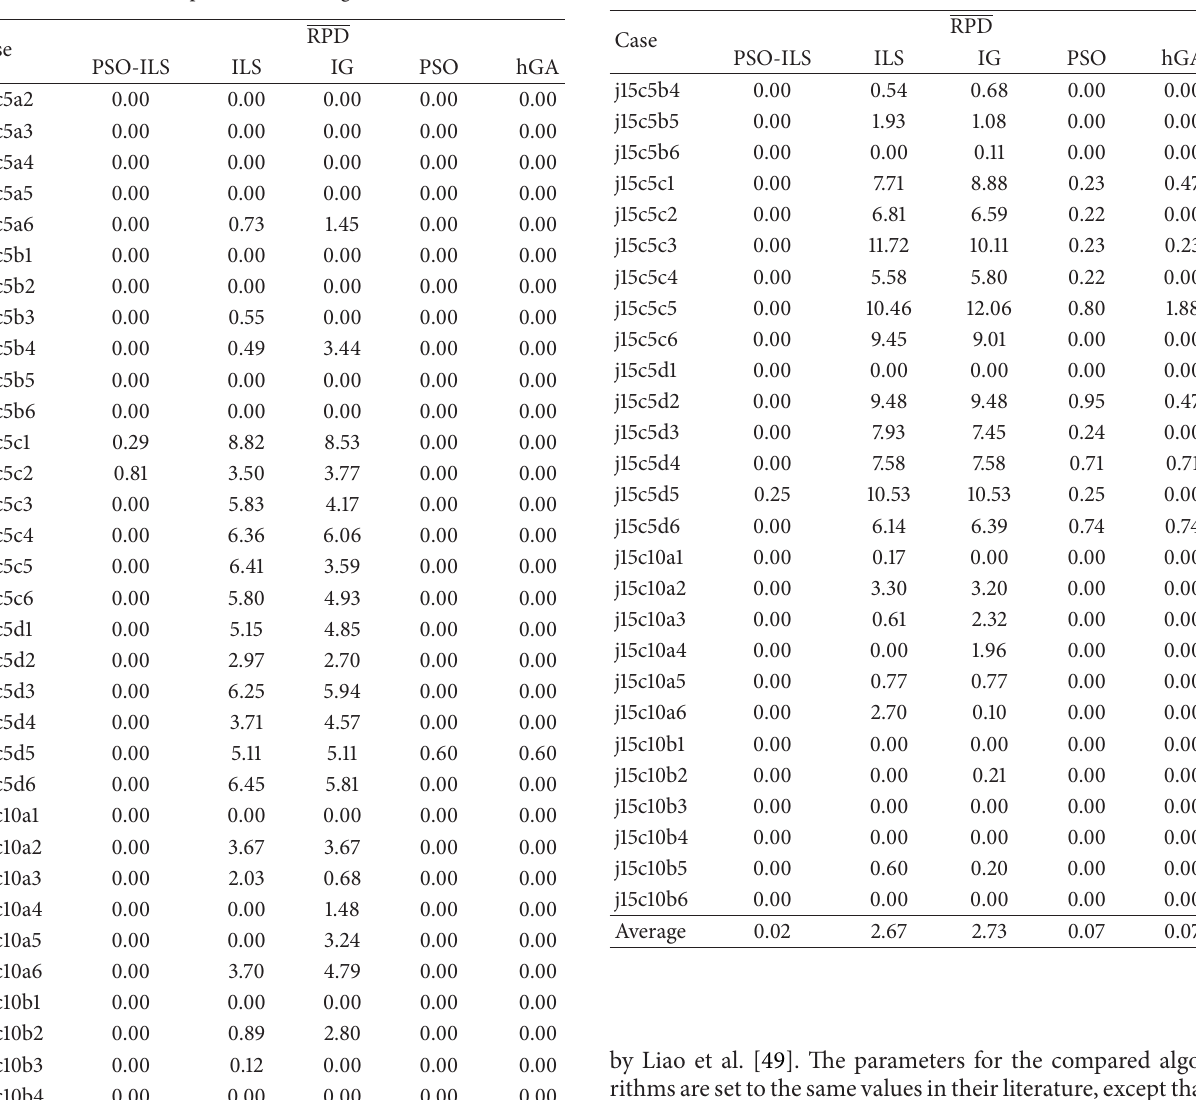
Table 13: Comparisons of average RPD